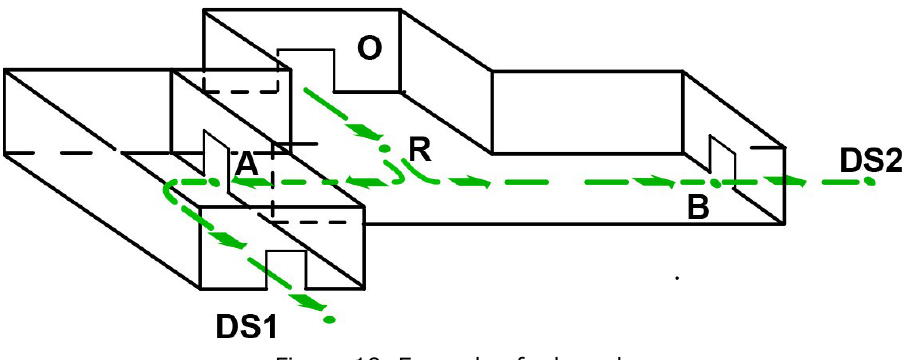
Figure 19. Example of a